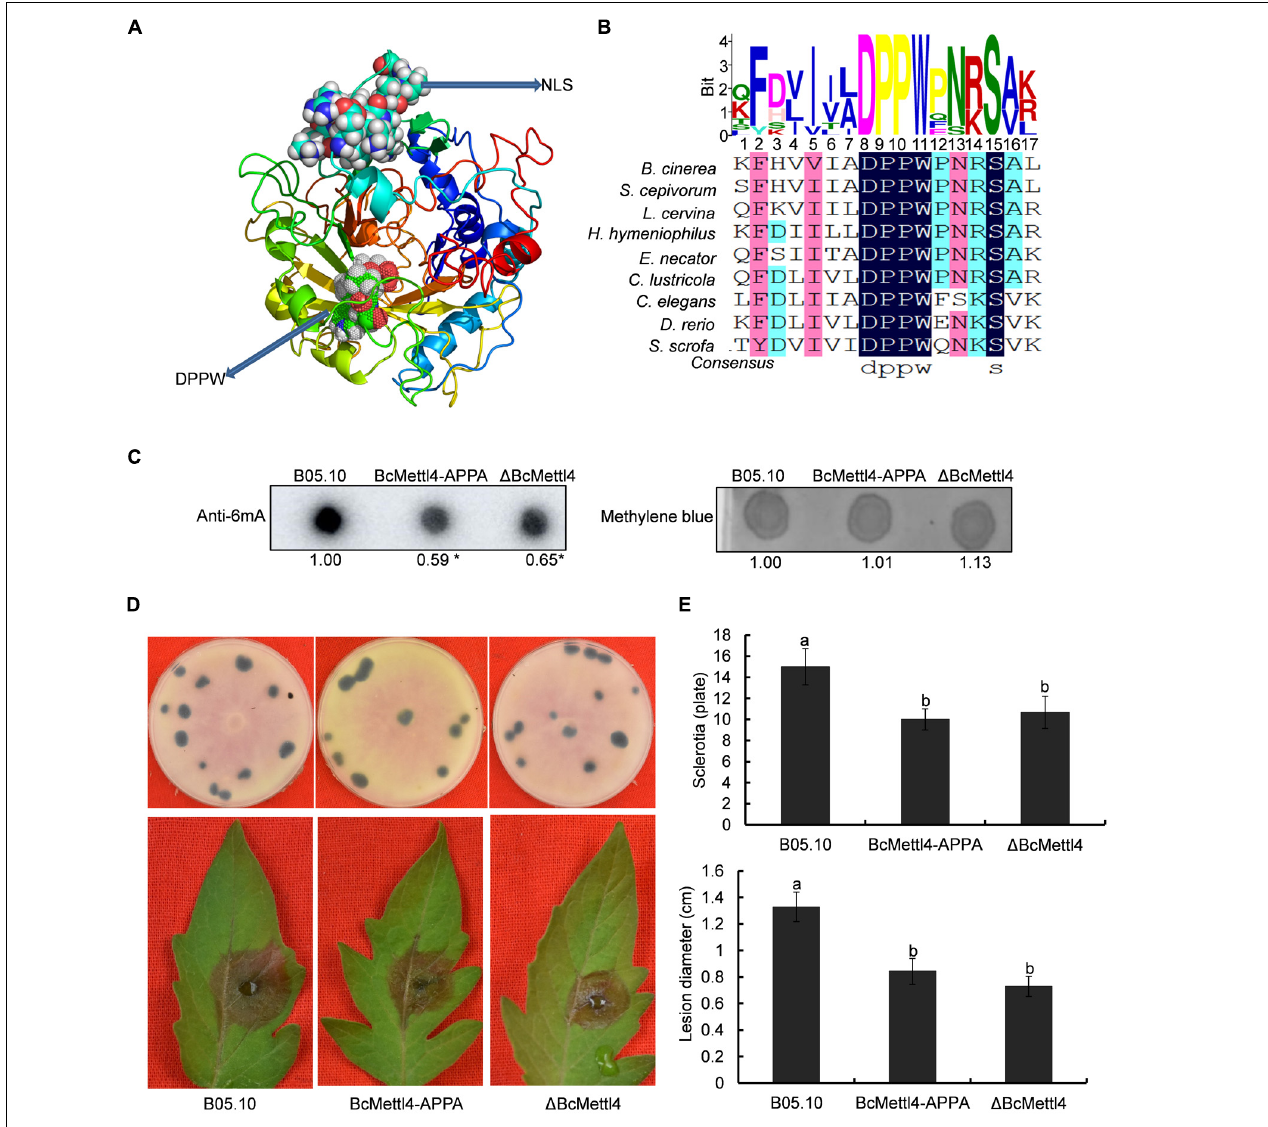
FIGURE 5 | Impact of BcMettl4 loss-of-function on DNA modification, pathogenicity, and sclerotia formation of B. cinerea . (A) Three-dimensional structure of BcMettl4 modeled were predicted by I-TASSER. (B) Sequence alignment of motifs in methyltransferase form B. cinerea , Sclerotium cepivorum , Lachnellula cervine , Hyphodiscus hymeniophilus , Erysiphe necator , Coniella lustricola , Caenorhabditis elegans , Danio rerio, and Sus scrofa . (C) Dot blot assay of 6mA in the indicated strains. A total of 200 ng DNA was investigated on each dot. The relative ratio of 6mA in wild-type strain B05.10 and point mutant BcMettl4-APPA was calculated by ImageJ. The asterisk represents significant difference at p < 0.05. (D) The disease lesions caused by various strains following inoculation on tomato leaves for 3 days and the sclerotia formation of various strains after grown in darkness for 30 days. (E) Lesion diameter of the strains inoculated on tomato leaves and the number of sclerotia in various stains. Error-bars were from three experiments. For lesion diameter, nine leaves were investigated in one biological experiment. Three plates were used to count sclerotia. Tukey’s test was used to calculate significance. The same letters marked on the columns were not significantly different at p <